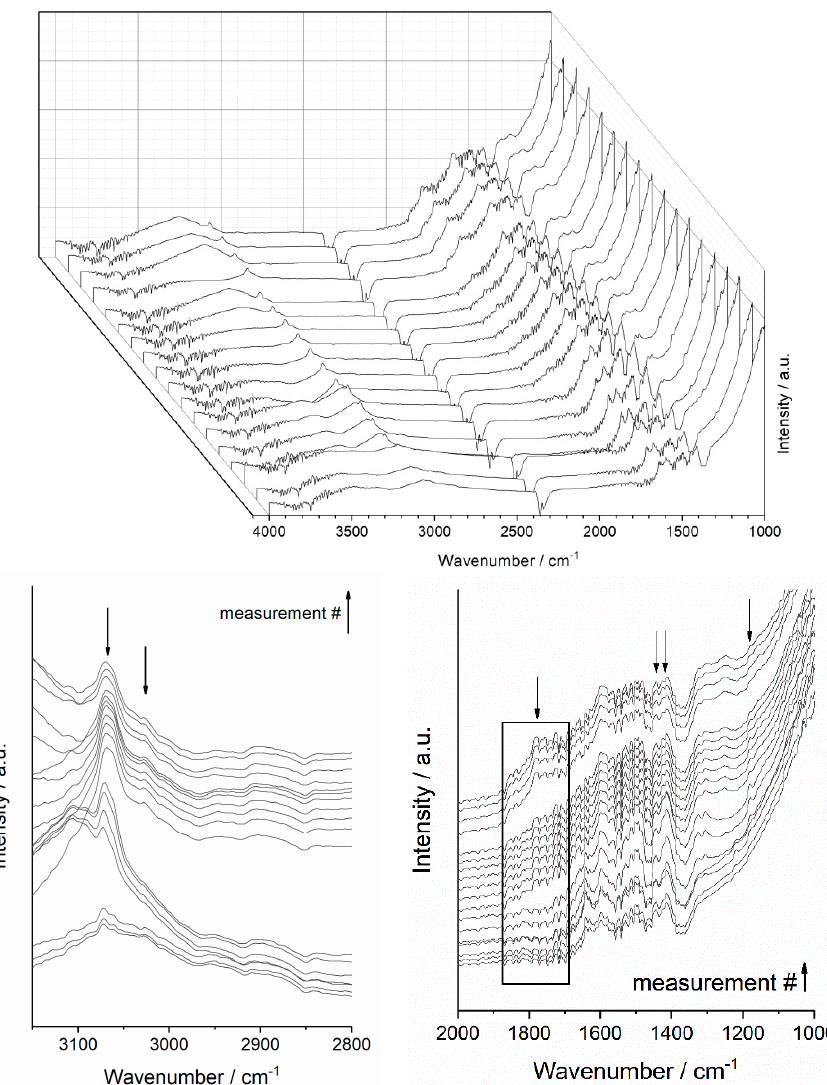
Figure 2. Operando DRIFT spectra of PdAu5NbTi catalyst recorded during the ageing test.